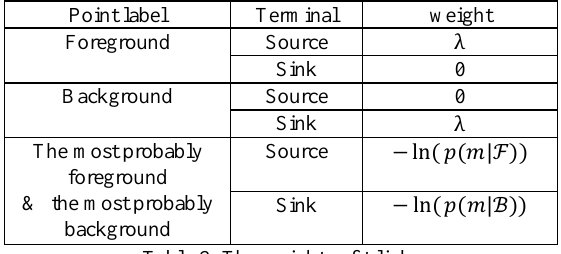
Table 2. The weights of t-links